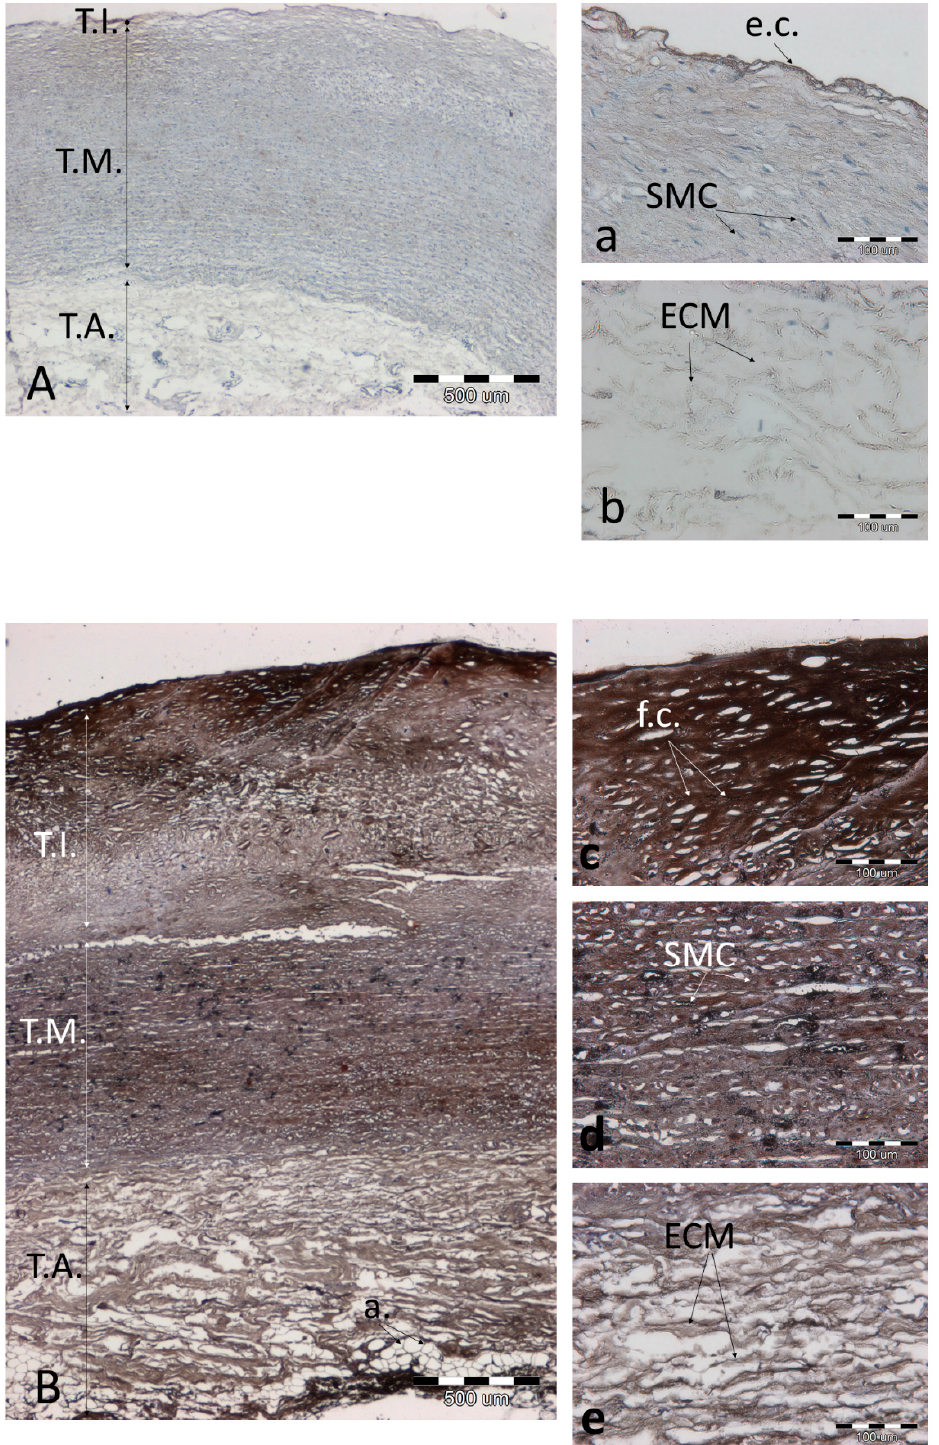
Figure 9. The effect of von Kossa staining in a representative aorta at a low level of atherosclerosis ( A ,( a , b )) and an aorta at a high degree of atherosclerosis ( B ,( c – e )). A , B —the entire aortic section, 40× magnification, scale bar 500 μ m; ( a – e )— magnification 200×, scale bar 100 μ m. Abbreviations in figures: T.A.—tunica adventitia; T.I.—tunica intima; T.M.—tunica media; ch.c.—cholesterol clefts; v.v.—vasa vasorum; f.c.—foam cells; SMC—smooth muscle cells; e.c.—endothelial cells; a.—adipocytes; ECM—extracellular matrix; MP—macrophages.